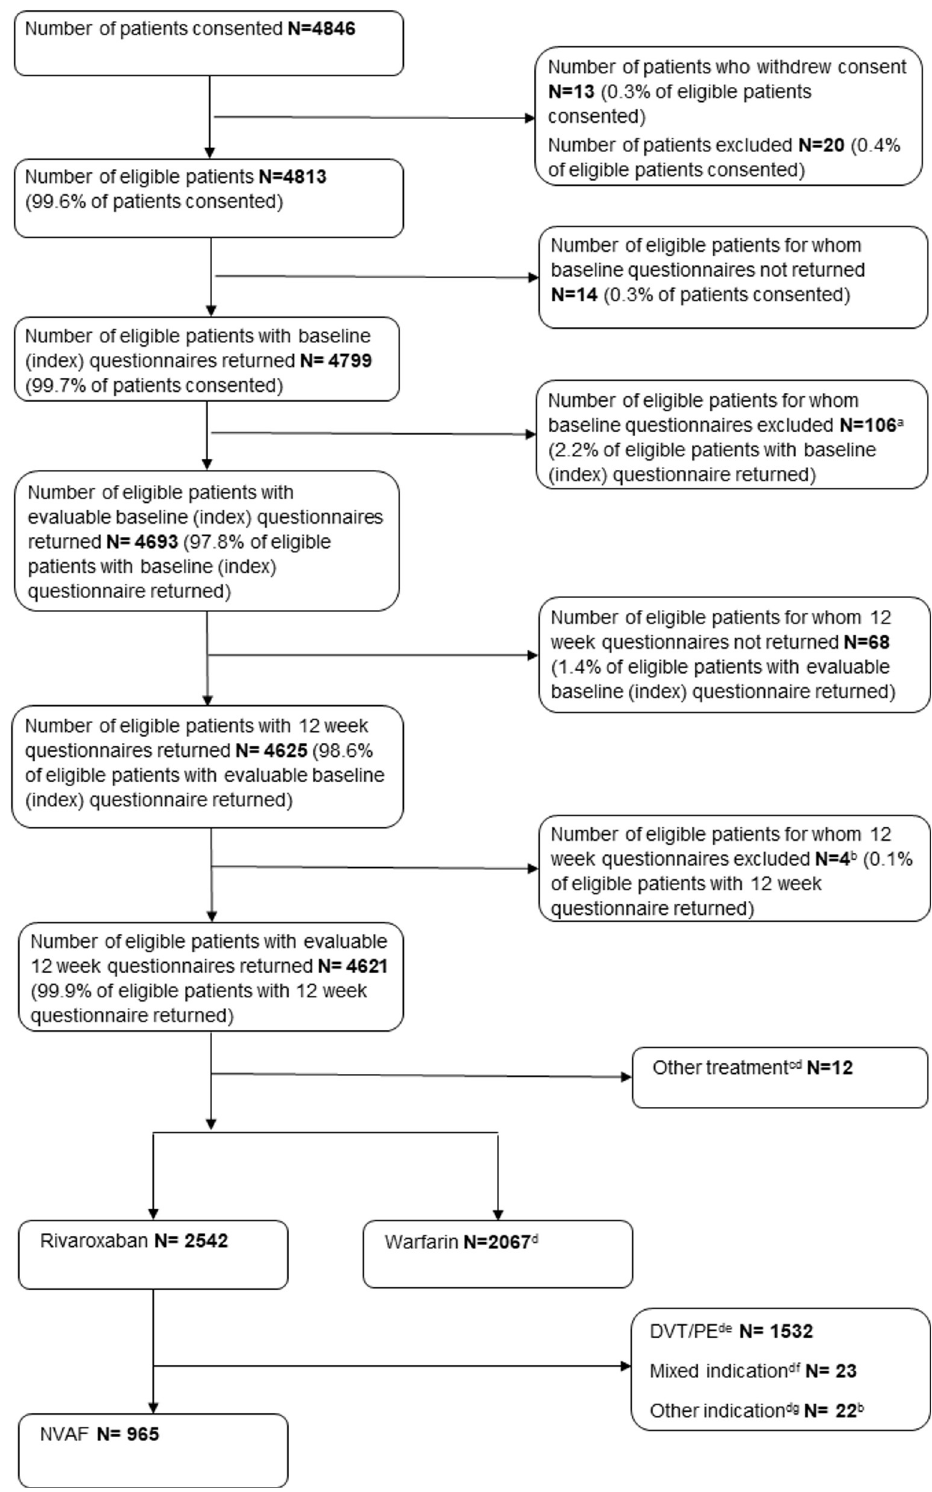
Fig 2. STROBE flowchart of the number of patients recruited over the course of the study. a Patient incorrectly identified (n = 87); did not start treatment (n = 13); decision to treat made in primary care (n = 4); questionnaire incomplete (n = 1); enrolled in another study (n = 1), b Patient incorrectly identified (n = 4), c Dalteparin (n = 10);